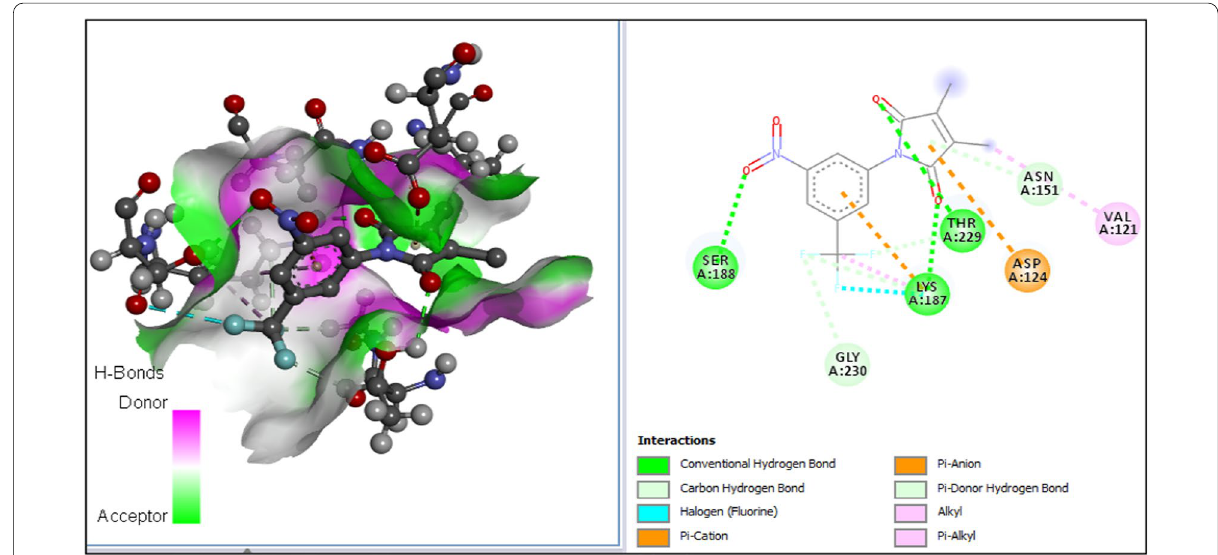
Fig. 10 2D and 3D view of the interaction between N12 and PdxK receptor